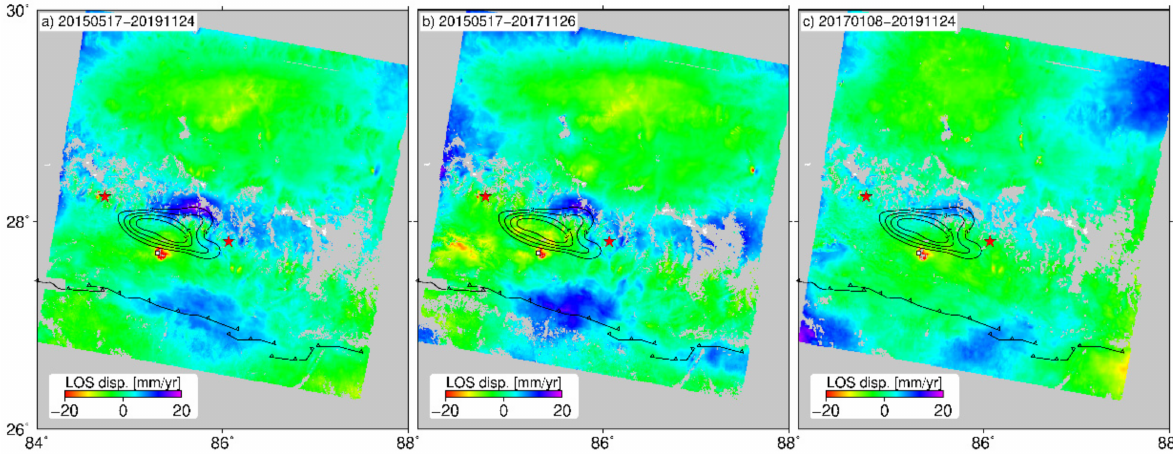
Figure 8. Average post-seismic deformation rate derived from ALOS-2 data in different time periods after the mainshock, ( a ) 4.5 yr after the mainshock, ( b ) 2.5 yr after the mainshock, ( c ) 1.5–4.5 yr after the